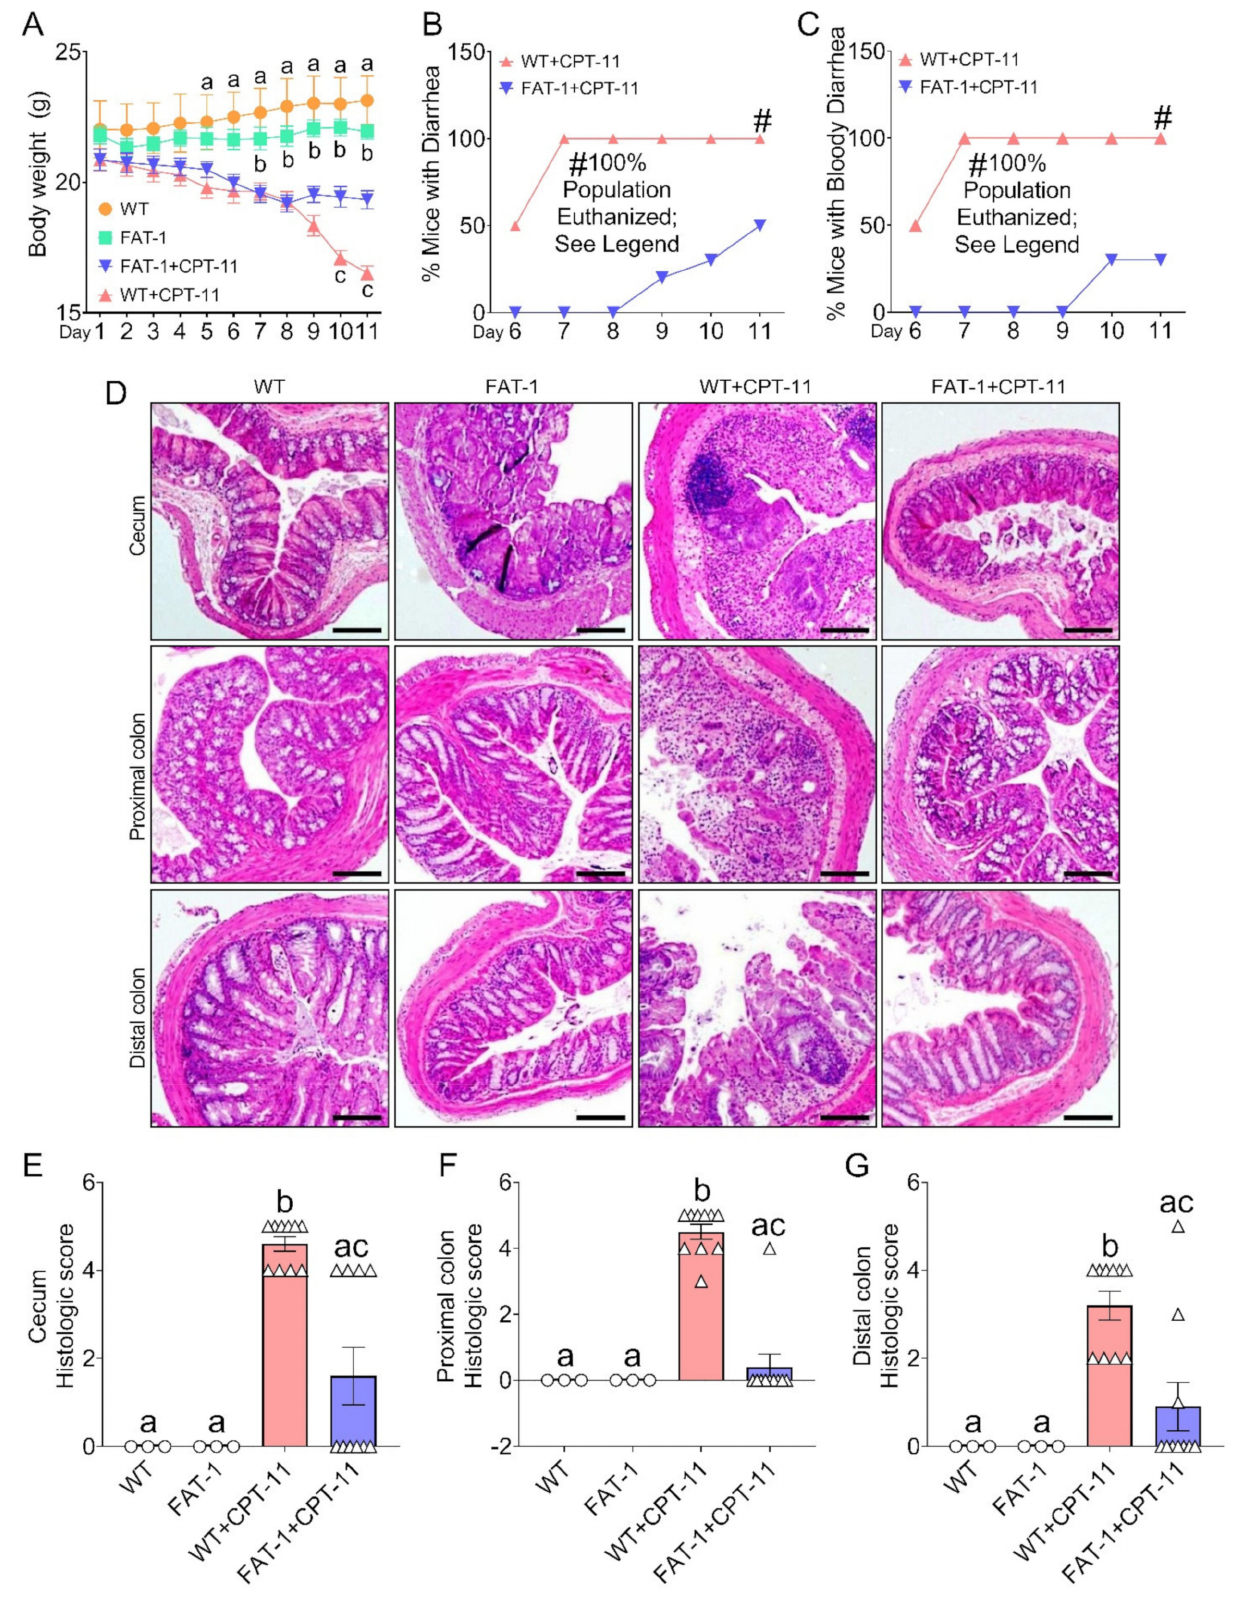
Figure 1. Decreased tissue n-6/n-3 ratio reduces CPT-11-induced gastrointestinal toxicities . Male, five-week-old wild type (WT) and FAT-1 transgenic mice fed an identical corn oil diet were arranged into four groups. Mice from WT+CPT-11 and FAT-1+CPT-11 groups and WT and FAT-1 control groups were subjected to nine consecutive days of treatment with intraperitoneal injections (i.p.,)